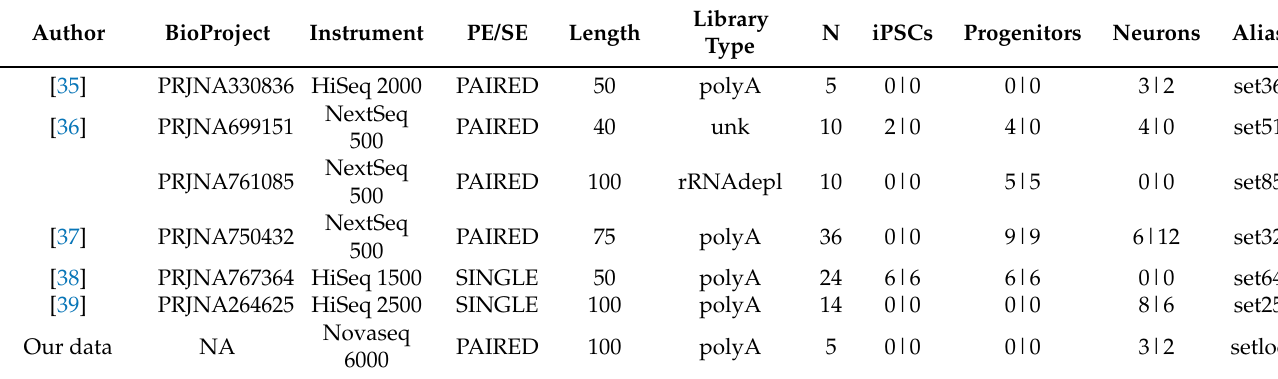
Table 3. Characteristics of the datasets